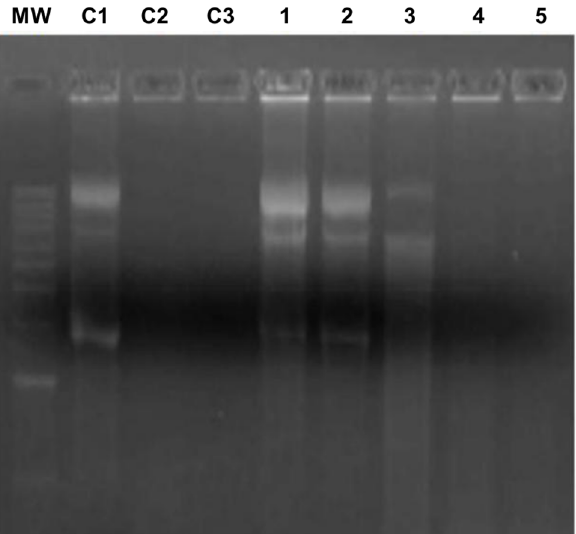
Fig 5. Neutralization of M . meleagridis membrane-associated endonuclease activity. Nuclease activity neutralization was tested with three controls (lanes C1, C2, and C3). Lane C1, plasmid pCR2.1 DNA incubated in reaction buffer only; Lane C2, plasmid pCR2.1 DNA incubated with untreated M . meleagridis cells; Lane C3, plasmid pCR2.1 DNA incubated with intact M . meleagridis cells that had been treated with rabbit antiserum against GST. Lanes 1 – 5, plasmid pCR2.1 DNA incubated with M . meleagridis cells treated with rabbit anti-GST-Mm19 antiserum diluted 1/10, 1/100, 1/1000, 1/2000, or 1/4000, respectively. Lane MW, 1 kb DNA ladder (Amersham). sequences in other mycoplasmas ( M . bovis , M . mycoides subspecies mycoides and M . agalac-